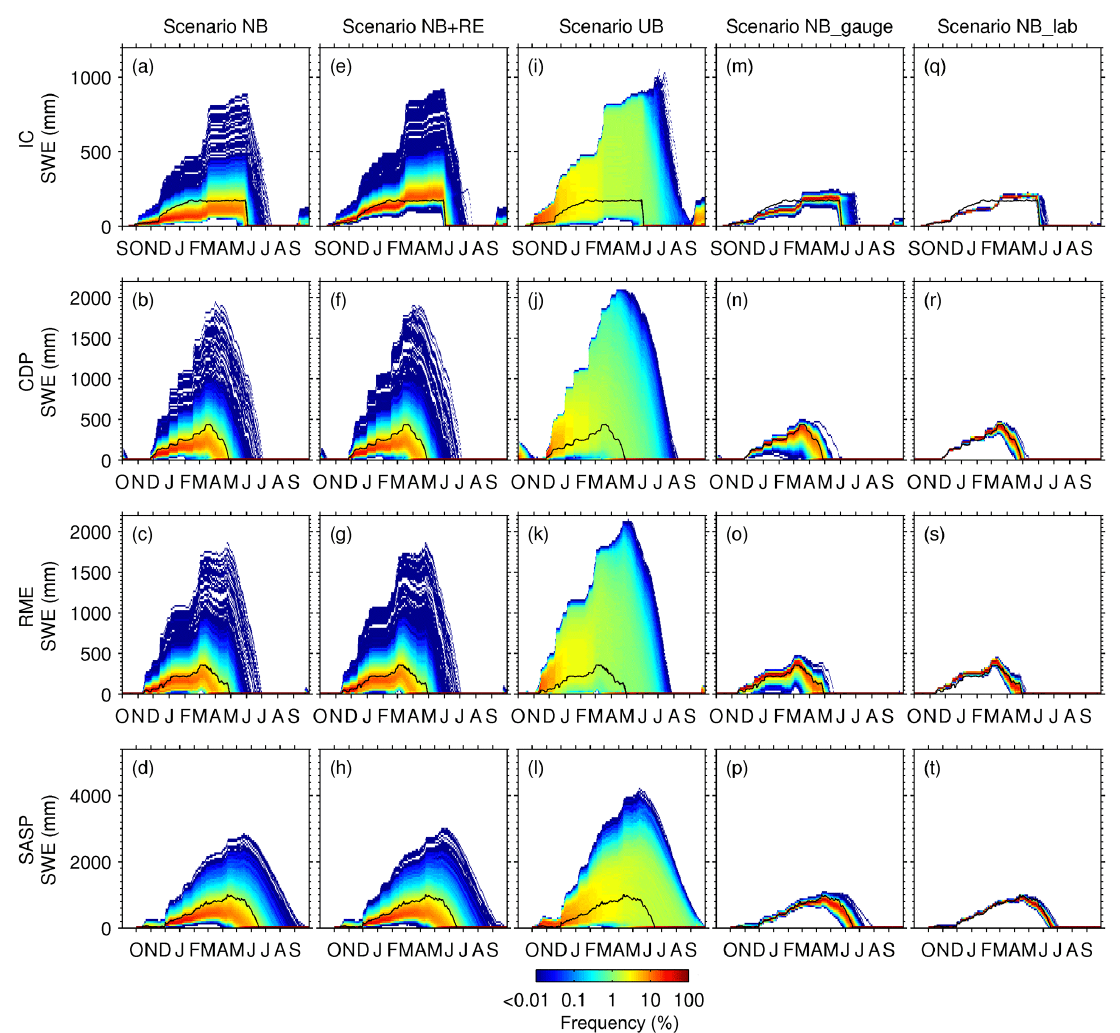
Figure 3. Observed (black line) and modeled SWE (color density plot) at the four sites across the five uncertainty scenarios (see Fig. 1 and Table 3). The number of model simulations in the density plots varies with the site and scenario (see Table 4). The density plots were constructed using 100 bins in the SWE dimension with relative frequency tabulated in each bin each day. Note the frequency color bar is on a logarithmic scale. Sites are arranged from top to bottom in order of increasing elevation and decreasing latitude. Scenarios are defined as normally distributed bias (NB), normally distributed bias and random errors (NB + RE), uniformly distributed bias (UB), normally distributed bias with precipitation gauge uncertainty (NB_gauge), and normally distributed bias at laboratory error magnitudes